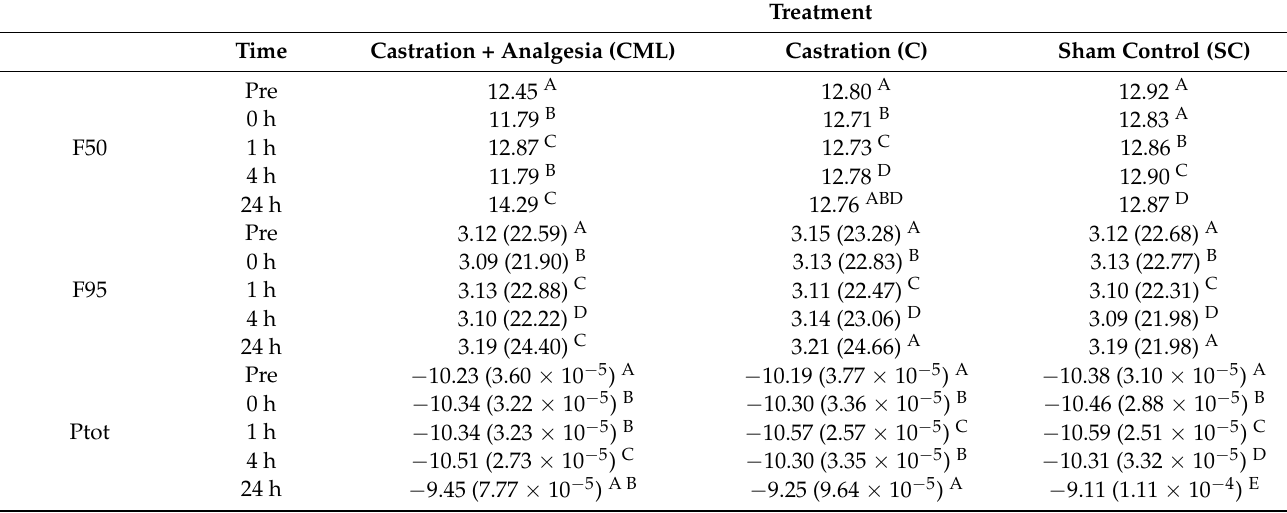
Table 3. Predicted means for the measurement parameters of median frequency (F50), 95th percentile power (F95) and total power (Ptot) with back-transformed values in parenthesis, for each treatment groups: castration + analgesia (CML), castration (C), and sham control (SC) ( n = 8 for all treatments); for time points pre (baseline), 0, 1, 4 and 24 h post-castration. F50 did not require data transformation, and therefore model predicted means are presented. Means between time points within a treatment group (column) with differing superscripts ABCDE are significantly different. Treatment